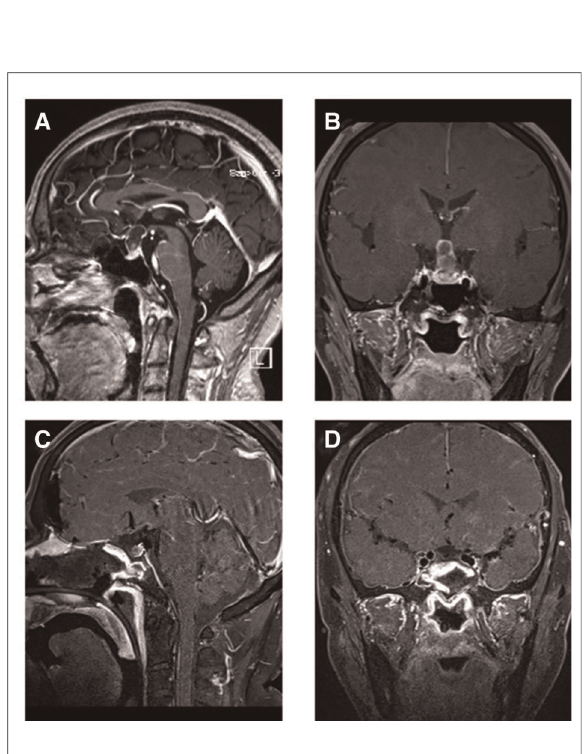
FIGURE 2 T1-weighted MRI image with contrast enhancement of a suprasellar craniopharyngioma. ( A ) Preoperative sagittal view. ( B ) Preoperative coronal view. ( C ) Postoperative sagittal view. ( D ) Postoperative coronal view. Note in ( C ) and ( D ) the autologous fat employed intradurally to fi ll the empty space within the suprasellar after tumor